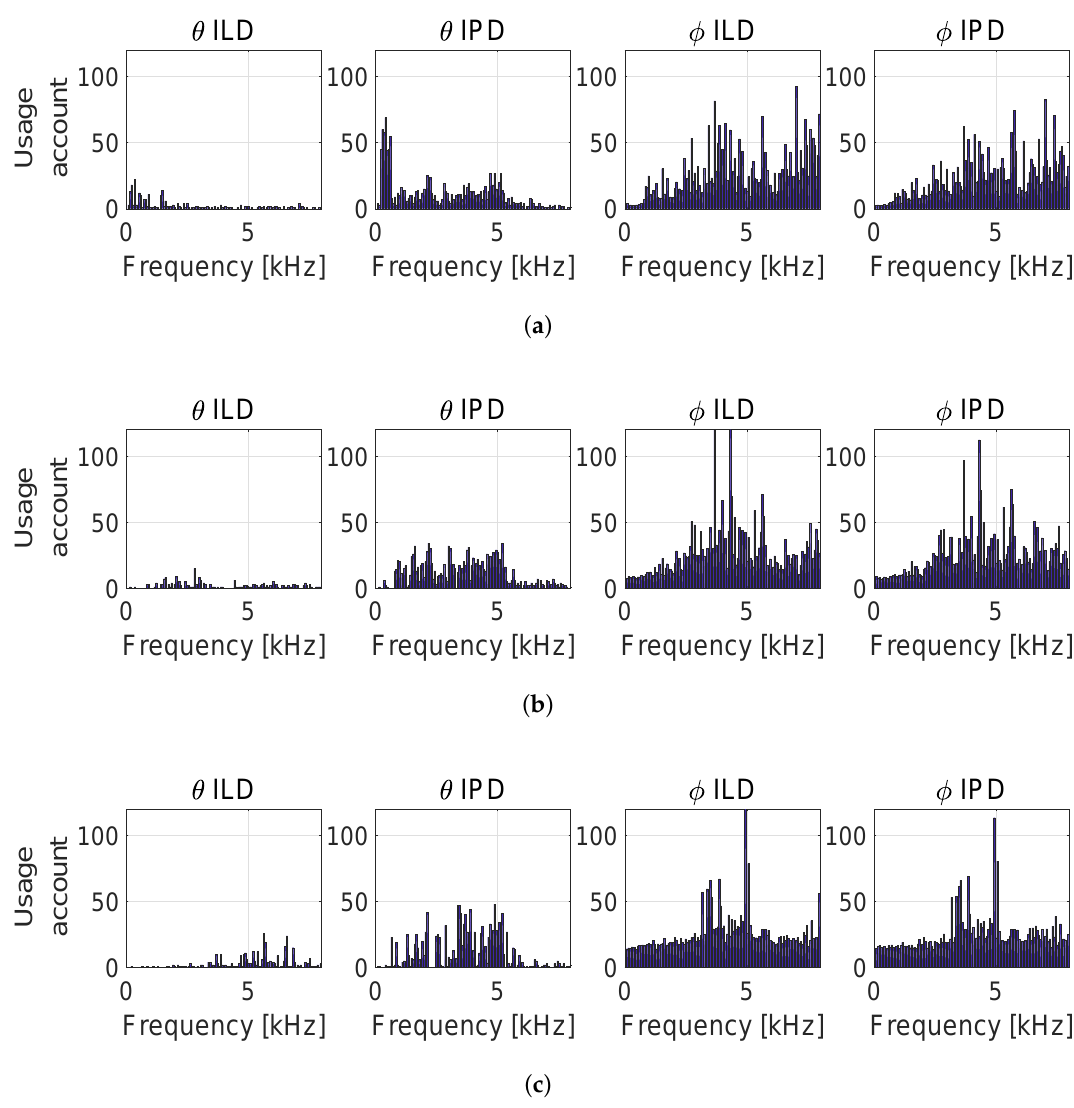
Figure 4. Feature Usage Accounts for training condition ( a ) SNR = ∞ ; ( b ) SNR = 20 dB and ( c ) SNR = 10 dB. The first two columns shows the feature usage for azimuth model and the last two columns shows the average feature usage for elevation